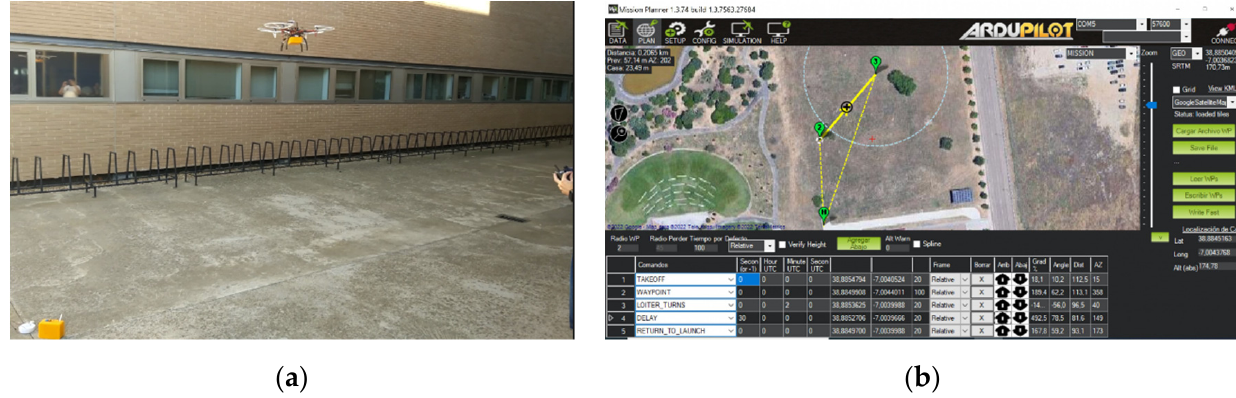
Figure 10. Flight tests: ( a ) manual flight test; ( b ) autonomous flight test.